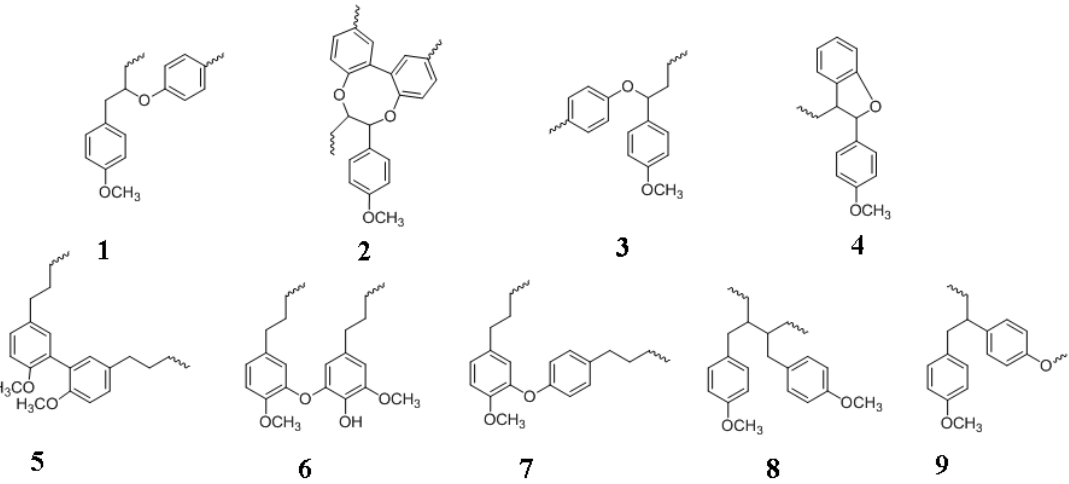
Figure 5. Lignin crosslinks. 1 , 8-O-4/ β -O-4 phenylpropane β -arylether; arylglycerol- β - arylether; ~50% softwood lignin; 2 , dibenzodioxocin; ~20% softwood lignin along with 5- 5 links; 3 , phenylpropane α -arylether; ~7% softwood lignin; 4 , phenylcoumaran; ~10% softwood lignin; 5 , 5-5, biphenyl; ~20% along with dibenzodioxocin; 6 , 5-O-4 biphenylether; ~6% softwood lignin; 7 , 4-O-5 diarylether; 8 , β - β , pinoresinol; ~3% softwood lignin; 9 , 1,2-diarylpropane-1,3-diol; ~8% softwood